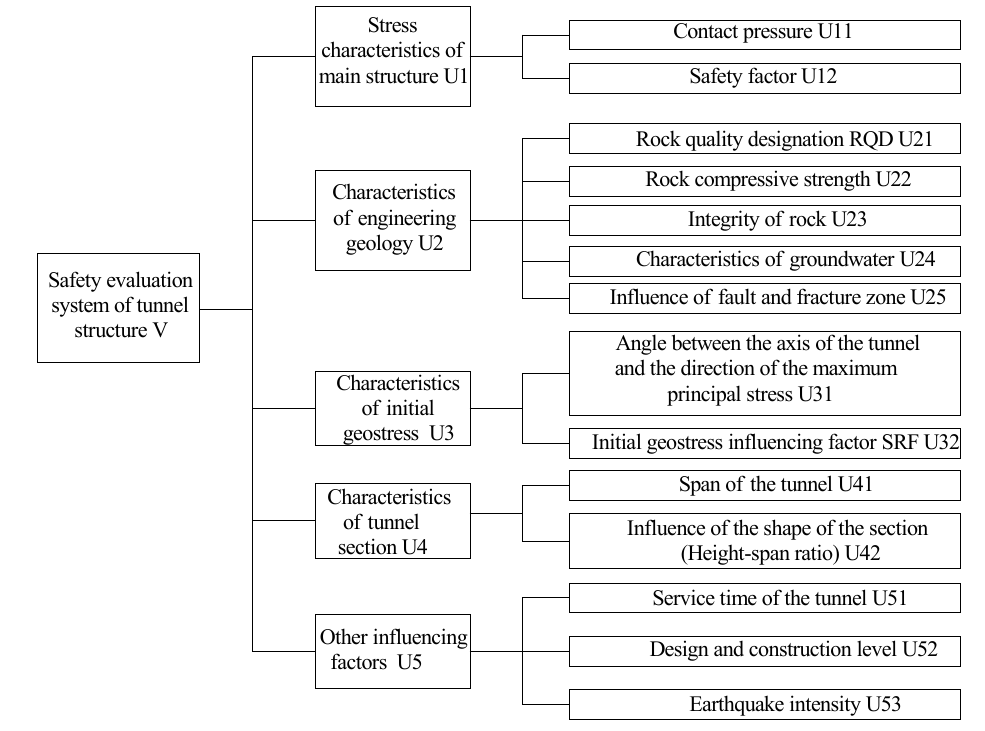
Figure 7. Fuzzy synthetic evaluation model.